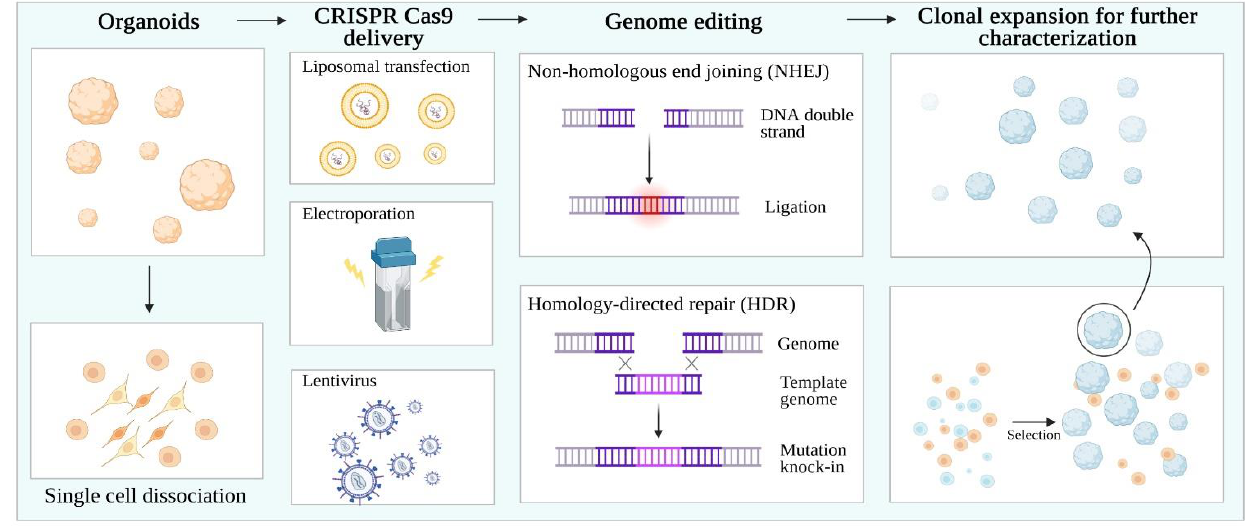
Figure 2. Genome editing of organoids using Clustered Regularly Interspaced Short Palindromic RepeatsCRISPR- Cas9technology.